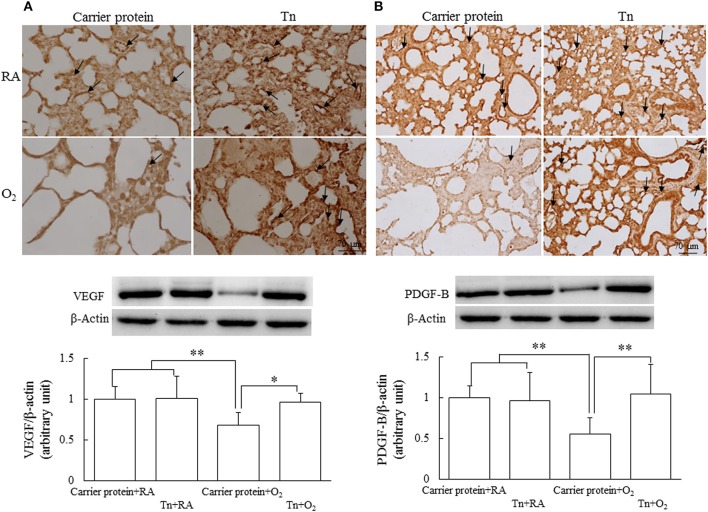
Representative immunohistochemistry and representative western blots and quantitative data for (A) VEGF and (B) PDGF-B protein expression in 14-day-old rats in the carrier protein + RA, Tn vaccine + RA, carrier protein + O2, or Tn vaccine + O2 group. The rats in the carrier protein + O2 group exhibited significantly lower vascular density and VEGF and PFGF-B expression than those in the carrier protein + RA or Tn vaccine + RA group. Maternal Tn immunization in hyperoxia-exposed rats improved vascular density and VEGF and PDGF-B expression to normoxic levels. *p < 0.05, **p < 0.01.